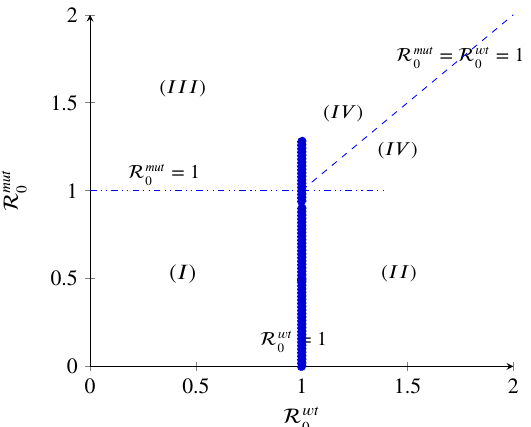
Figure 2. The diagram displays three regions with different qualitative behaviors in terms of the basic reproduction numbers. Region I: infection-free state; Region II: mut-free state; Region III: wt-free state; Region IV: co-existence of all